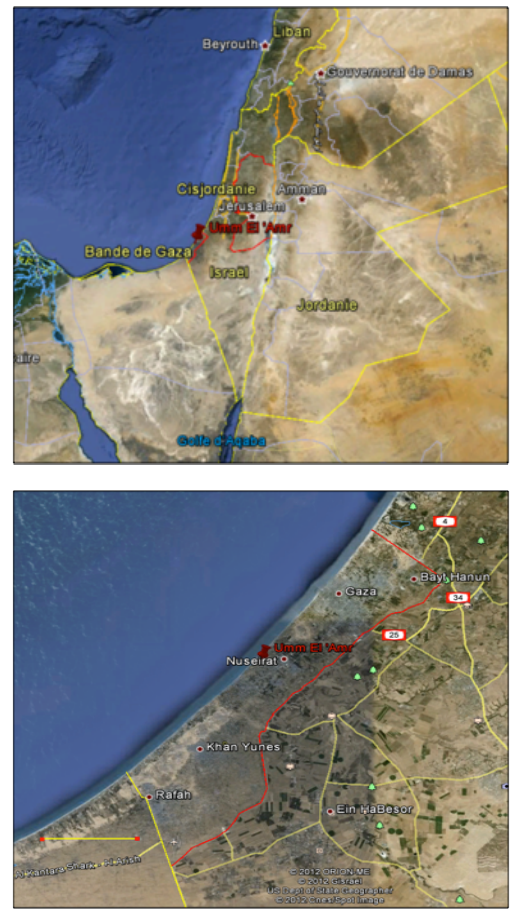
Figure 1: Location of the site (google